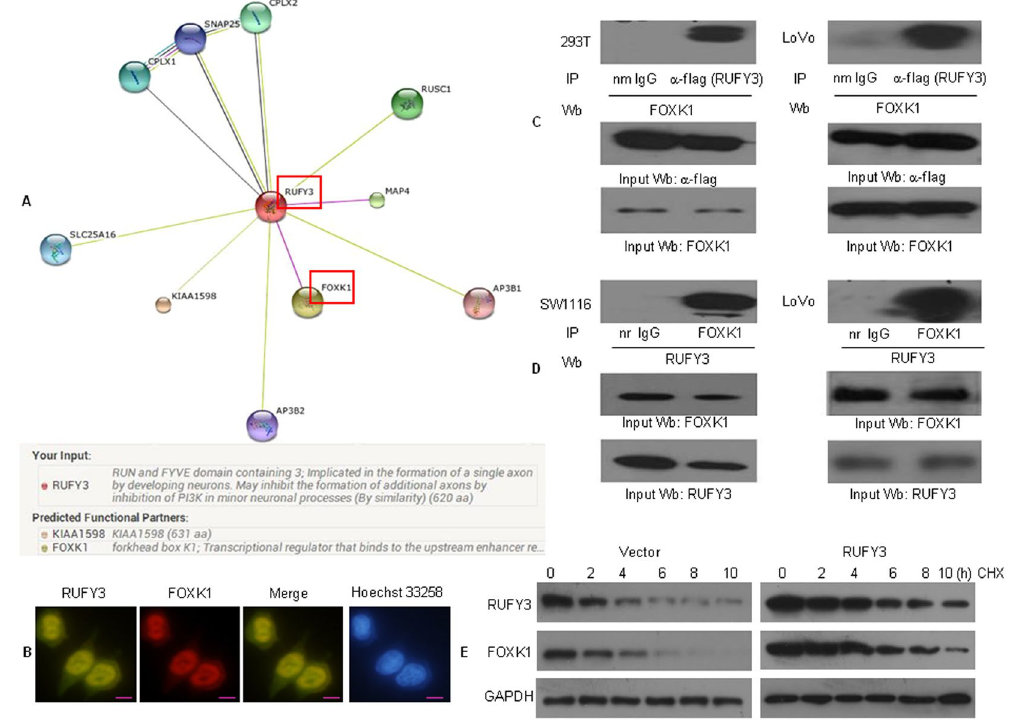
Figure 2. RUFY3 physically interacts with FOXK1 in CRC. ( A ) Potential RUFY3-binding partners were predicted using a STRING database. Red boxes represent protein-protein interactions. ( B ) Double staining of RUFY3 and FOXK1 in LoVo cells by indirect immunofluorescence, with the nuclei counterstained Hoechst 33258. Scale bars represent 20 μ m. ( C ) Flag-tagged RUFY3 plasmid was transfected into HEK293 and LoVo cells. Immunoprecipitation was performed with anti-flag antibody, and pre-immune normal mouse immunoglobulin G (nm IgG) was used as a control. Western blot analysis was performed with an anti-FOXK1 antibody. IP: immunoprecipitation; Wb: Western blot. ( D ) Cell lysates of SW1116 and LoVo cells were immmunoprecipitated by anti-FOXK1 antibody or the control antibody, normal rabbit immunoglobulin G (nr IgG). Western blotting was performed with anti-RUFY3 antibody. All experiments were repeated 2 to 3 times with similar findings. ( E ) Regulation of FOXK1 protein stability by RUFY3. At the start of the experiment, 50 mg/ml cycloheximide (CHX) was added to vector LoVo cells and to cells expressing RUFY3. Cells were harvested and lysates were prepared at the indicated times after the addition of cycloheximide. Western blotting was performed. The full-length blots/gels are presented in Supplementary Figure